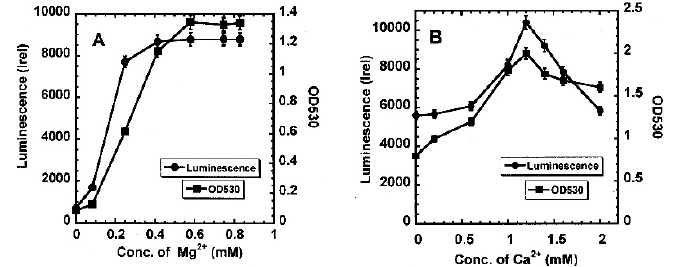
Figure 5. Optimization experiments with Mg 2 + and Ca 2 + ions. Influence of ( A ) Mg 2 + and ( B ) Ca 2 + on growth and luminescence.